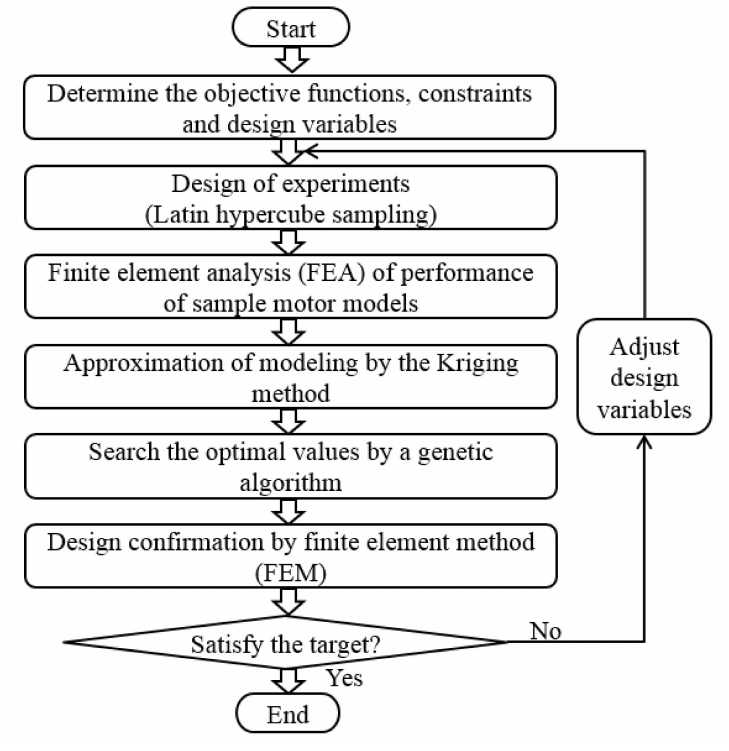
Figure 8. Optimal design